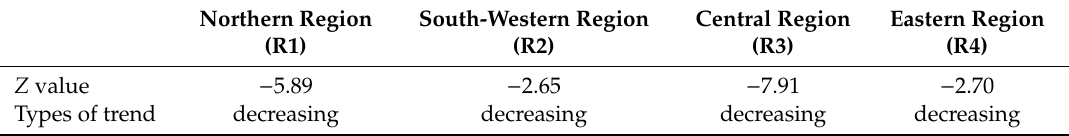
Table 4. Mann-Kendall test results for